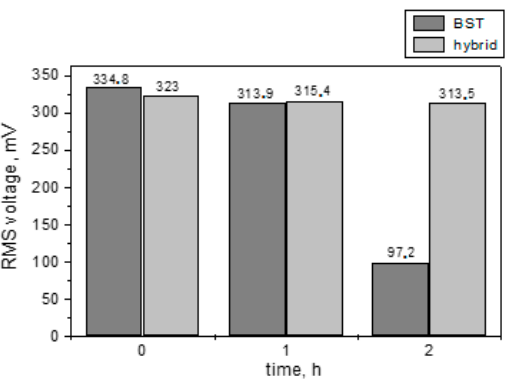
Figure 7. Degradation of the output RMS voltage for the BST and hybrid BST+PVDF-TrFE piezoelectric thin-film flexible transducers.